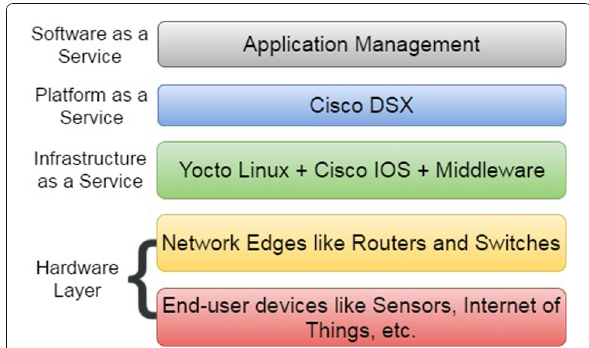
Fig. 2 Technical architecture of Cisco’s Fog Computing Platform. This figure shows all components from hardware to application layer